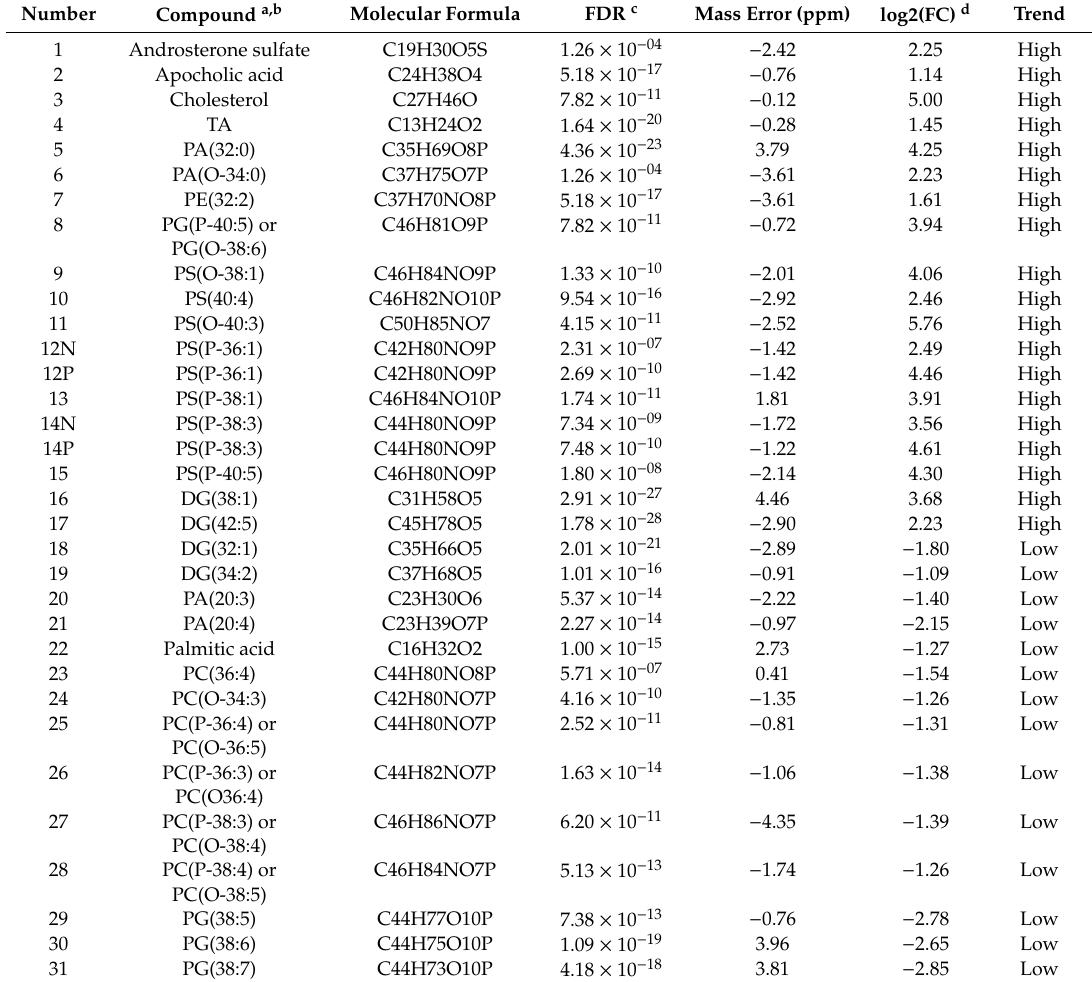
Table 2. Di ff erential features between colon cancer (CC) patients and control (CTR)